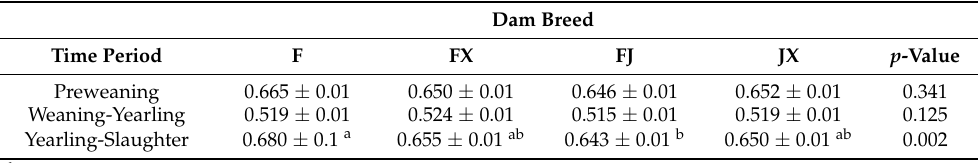
Table 3. Average daily gain (kg/day) throughout the study of beef-cross-dairy-breed progeny from Friesian (F), Friesian-cross (FX), Friesian–Jersey (FJ) and Jersey-cross (JX) dams. Values are least squared means, including the standard error of the